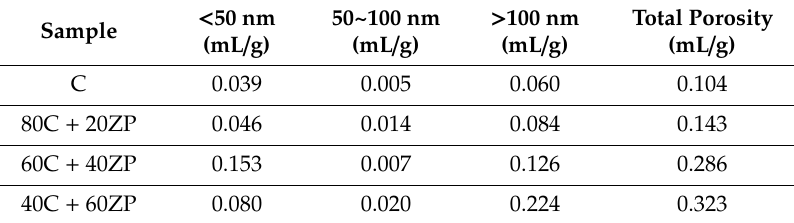
Figure 8. Pore size distribution curves of 28-day cured samples. Table 3. Pore structure parameters of the 28-day cured samples.